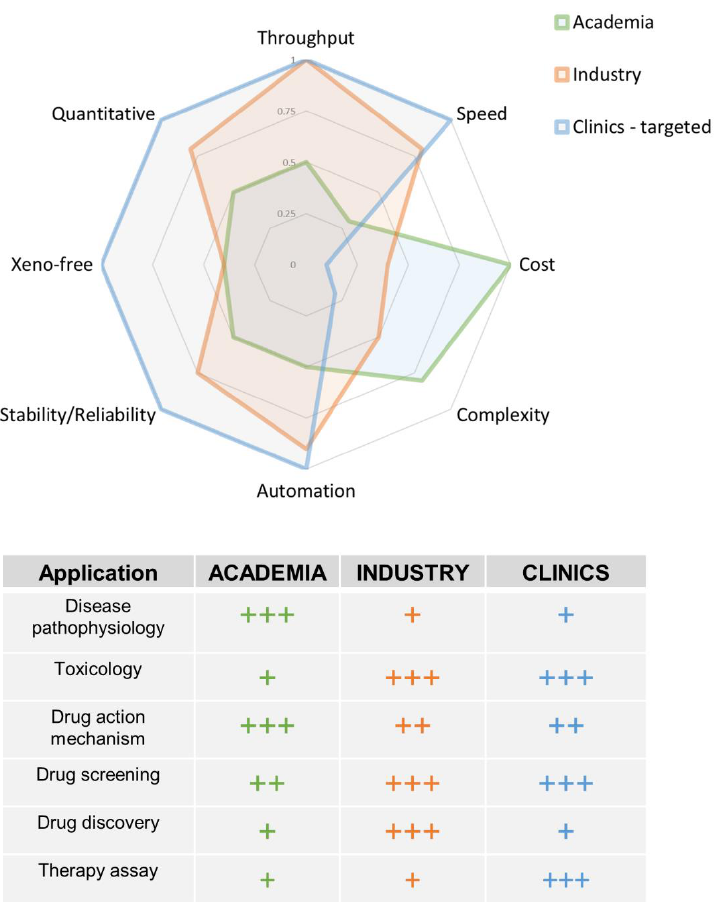
Figure 1. Boosting OoC into the clinics. ( Top ) Radar scheme comparing the main typical features and ( bottom ) applications of OoC for academia (green) and industry (orange), and the desired characteristics for being applied in the clinic (blue). The scores in the radar diagram range from 0 to 1, representing 1 the ideal performance. The symbols “+” in the table highlight the degree of importance of each application in academia, industry and clinic, representing “+++” the highest value .